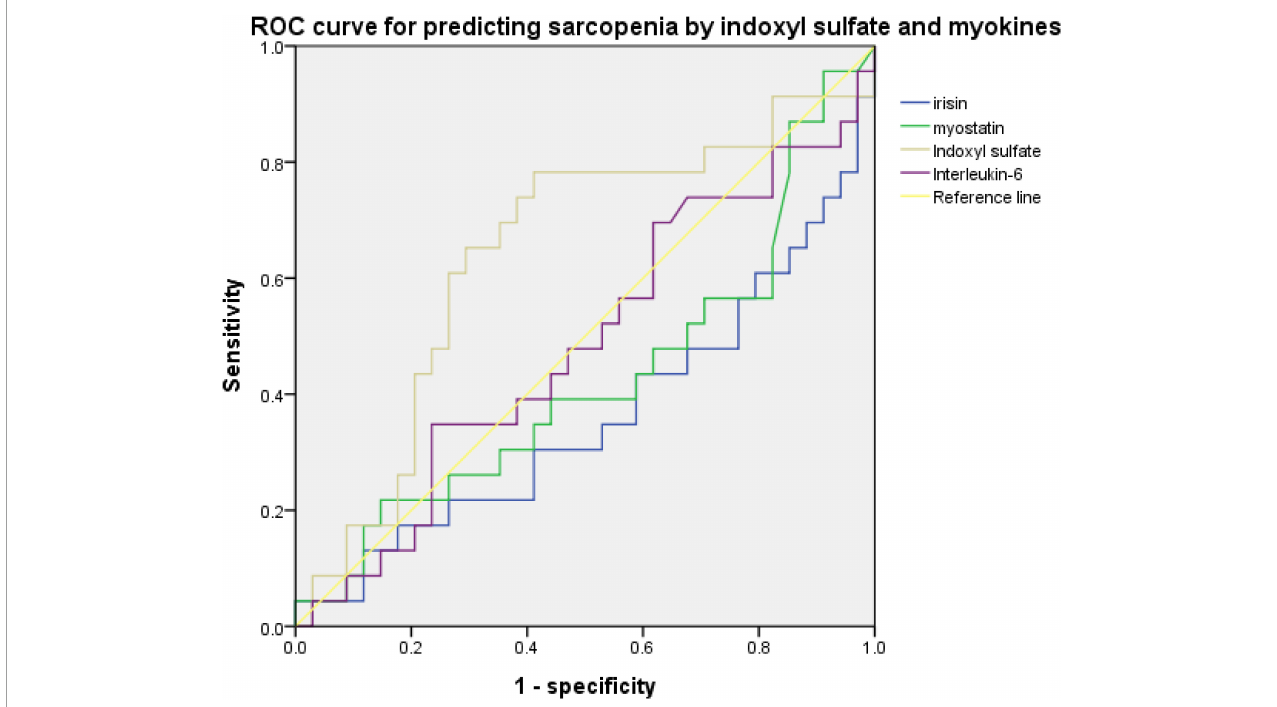
FIGURE2 ROC curve for predicting sarcopenia based on concentrations of indoxyl sulfate, irisin, myostatin, and Interleukin-6 (indoxyl sulfate: AUC: 0.642, 95% CI: 0.489–0.795, p = 0.071; irisin: AUC: 0.361, 95% CI: 0.208–0.513, p = 0.076; myostatin: AUC: 0.426, 95% CI: 0.269–0.0.583, p = 0.345; interleukin-6: AUC: 0.578, 95% CI: 0.429–0.727, p = 0.317).